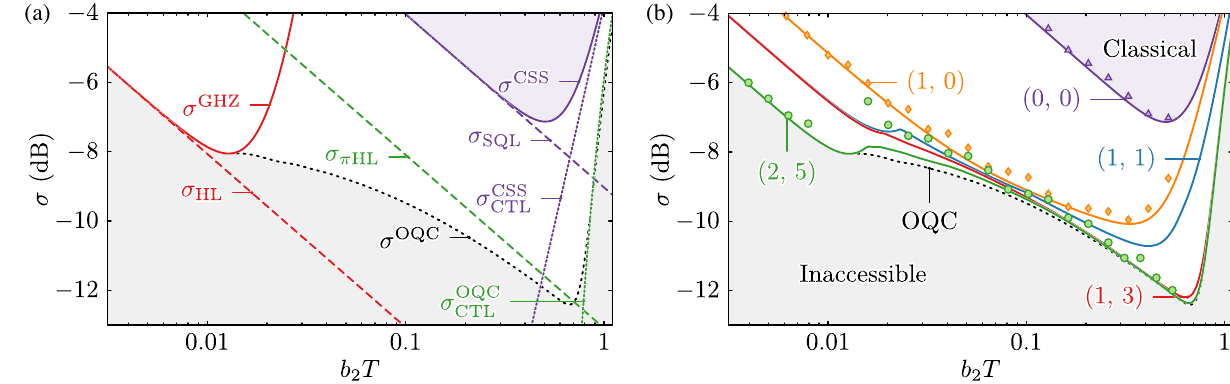
FIG. 10. Dimensionless Allan deviation σ [see Eq. (25)] of a N ¼ 64 flicker-frequency-noise-limited clock at constant averaging time τ as a function of the Ramsey interrogation time T rescaled to the bandwidth of the laser noise. The dotted black line indicates the instability of the optimal quantum clock (OQC). (a) Analytic expressions for the instability of coherent spin state (CSS) and GHZ state clock (solid lines) in comparison to quantum projection noise limits, namely the standard quantum noise limit (SQL), π -corrected Heisenberg limit ( π HL), HL (dashed lines), and the coherence time limits (CTL) of a CSS clock and the OQC (densely dotted lines). (b) Variational approximation of the OQC at increasing circuit complexities ð n show the numerically determined instability extracted from simulations of the full feedback loop of an atomic clock, described in detail in Appendix G, for a selection of optimized protocols. The numerical data are displayed only up to values of b 2 T where no fringe hop occurred within the 2 × 10 6 simulated clock cycles. Beyond this point an abrupt loss of stability was